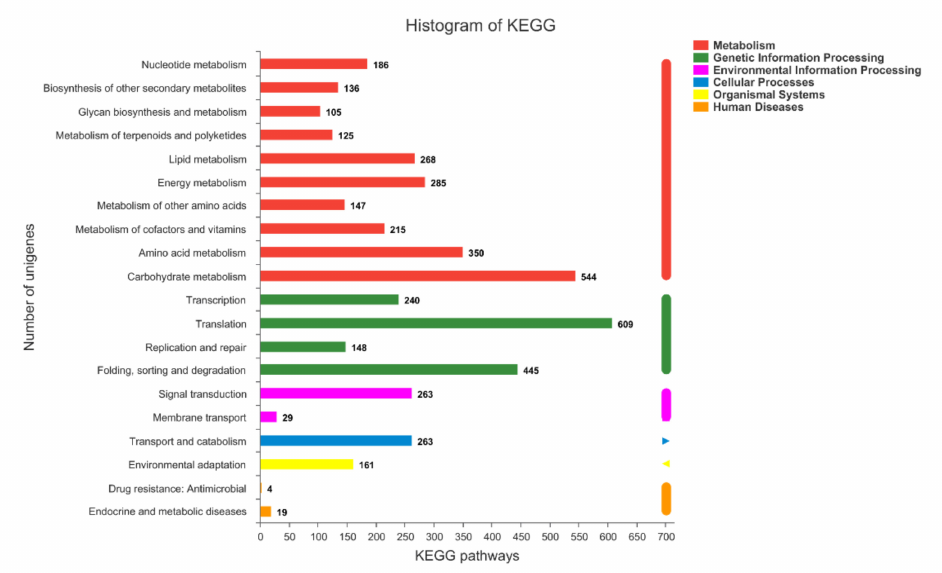
Figure 4. Function classification of unigenes of M. azedarach in KEGG